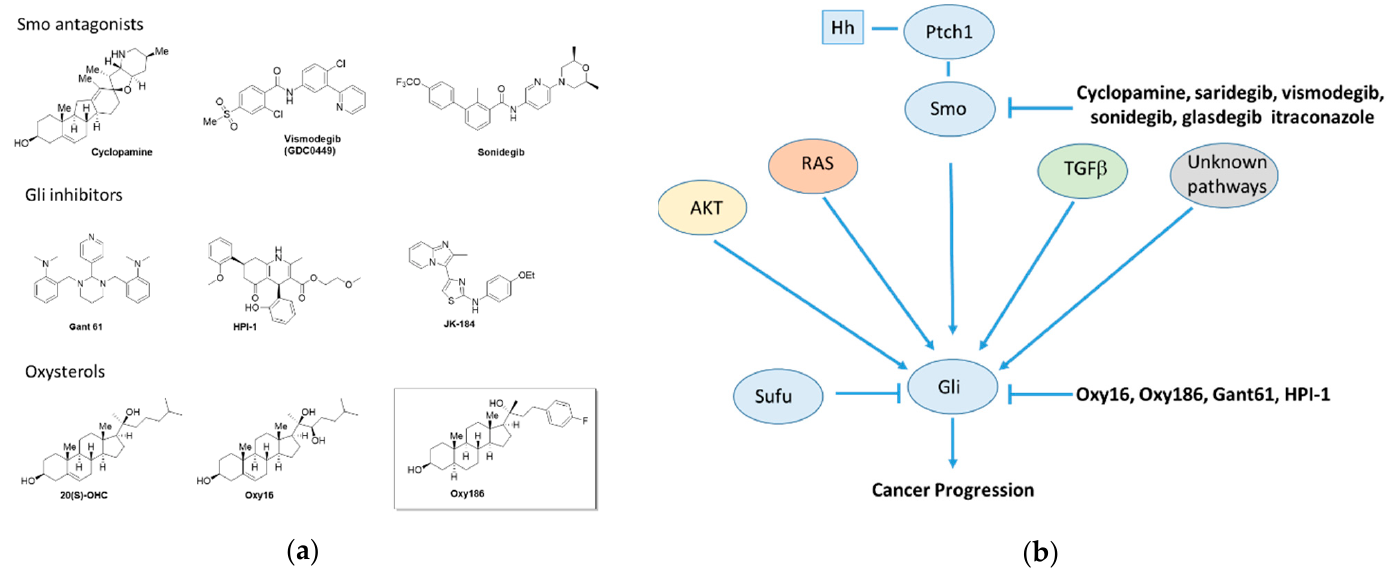
Figure 1. ( a ) Small molecule modulators of Hedgehog signaling and ( b ) canonical and non-canonical regulation of GLI and Hedgehog